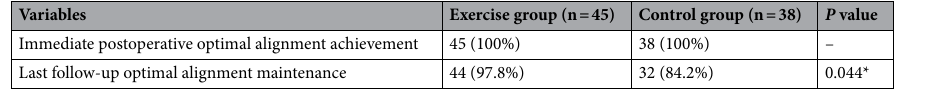
Table 3. Achievement and maintain of optimal sagittal alignment between two groups. * p <